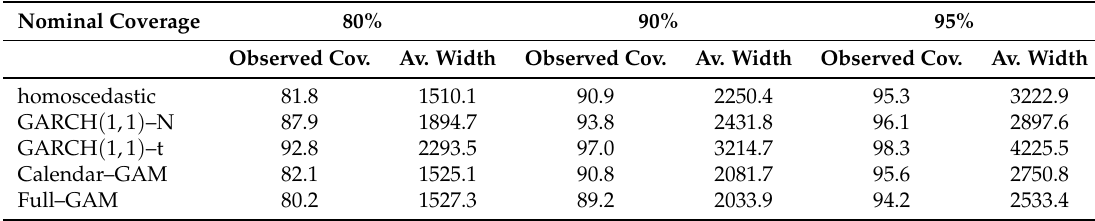
Table 8. Electricity demand for the northern zone. Out-of-sample predictive results for the year of 2019. For all of the models the MAE is equal to 500.8 MWh and MAPE is equal to 2.8%. Moreover, “observed cov.” stands for nominal coverage, and “av. width” is the mean interval forecasting width at the ( 1 − α ) level.